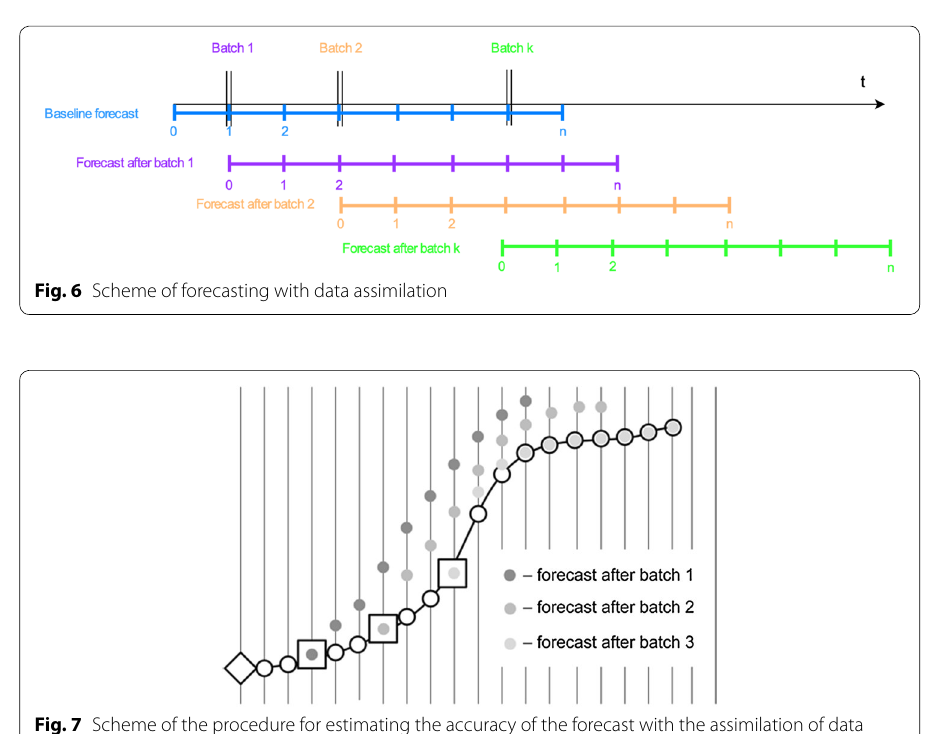
Fig. 7 Scheme of the procedure for estimating the accuracy of the forecast with the assimilation of data (the rhombus indicates the moment of generation of IM, the squares are batches which are used both for assimilation and the evaluating the results (batches of assimilation), the circles are batches which are used only for evaluating the results (batches of evaluation), the circles are the response values for various forecast